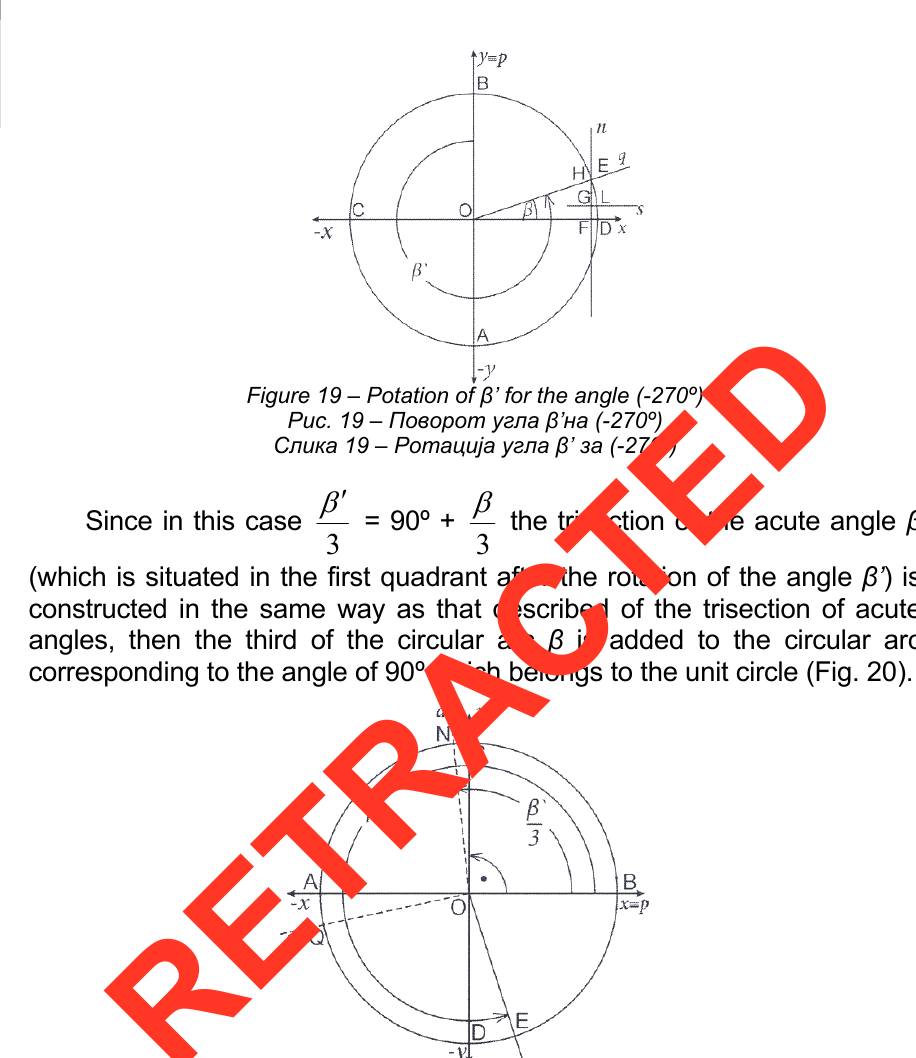
Figure 17 – Angle trisection of β ’ when the arm q belongs to the fourth quadrant Рис . 17– Трисекция угла β ’ в случае , когда луч q угла β ’ принадлежит четвертому квадранту Слика 17 – Трисекција угла β ’ када крак q угла β ’ припада четвртом квадранту The angle BOE is divided into three equal parts by the dashed lines